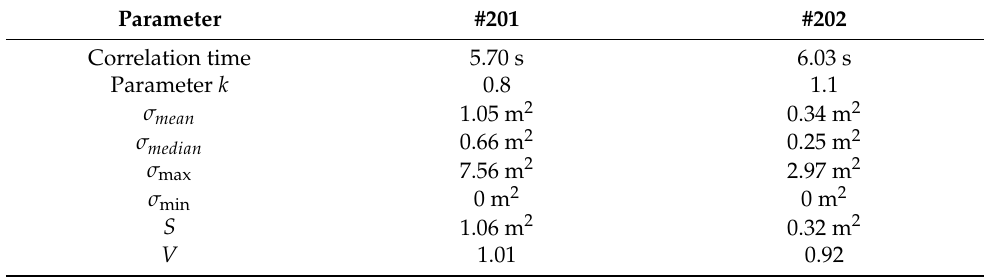
Table 4. Target RCS characteristic